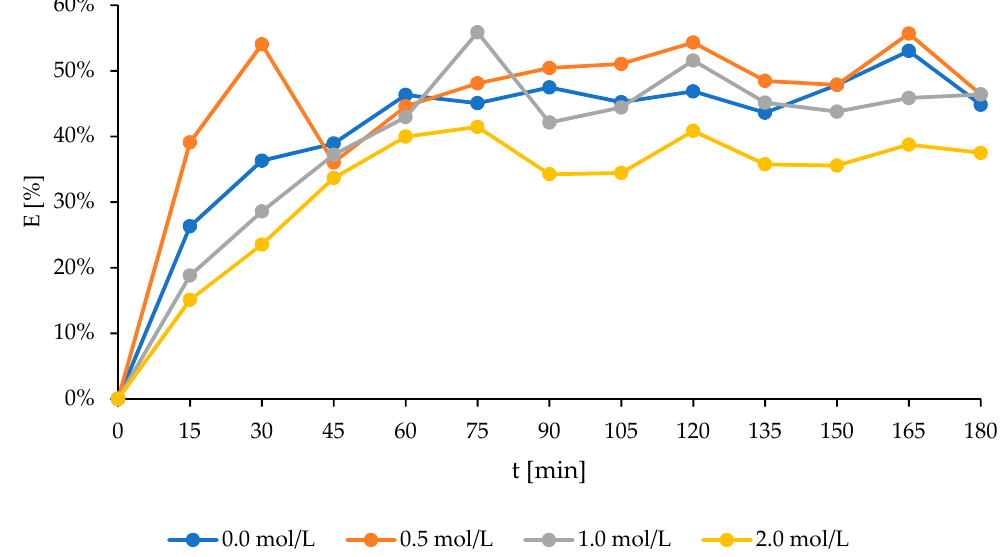
Figure 4. The e ff ect of using di ff erent NaCl solutions for the activation of Bentonite I on ammonium Figure 4. The effect of using different NaCl solutions for the activation of Bentonite I on ammonium ions removal e ffi ciency ions removal efficiency (E).